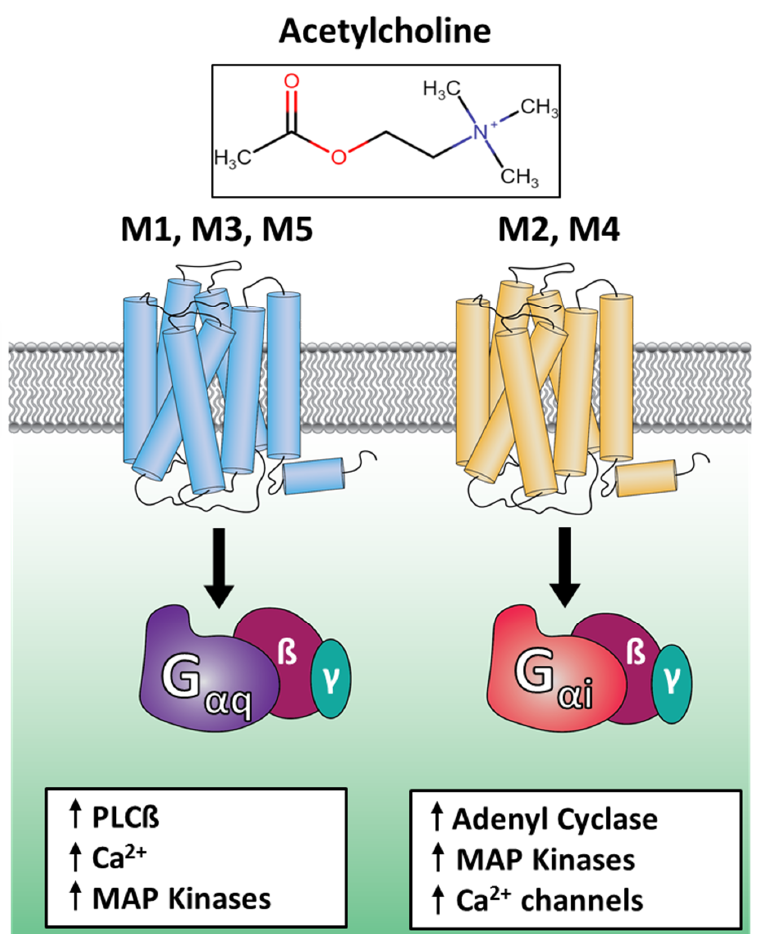
Figure 1. G protein selectivity and signaling differences in the muscarinic receptor family.